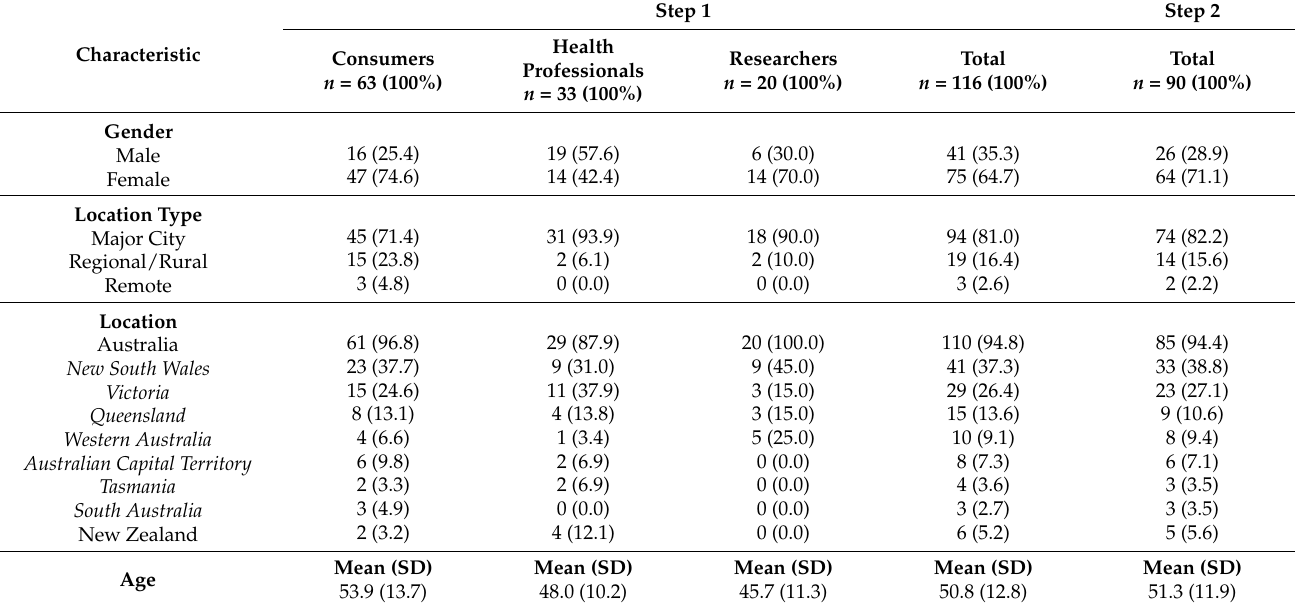
Table 3. Participant type, personal characteristics, and location of Phase 2 (Step 1 and Step 2)